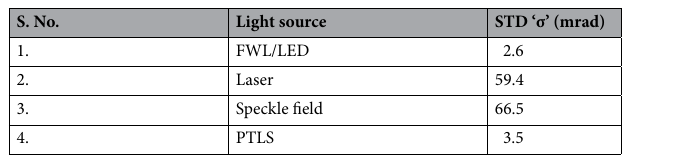
Table 1. Spatial phase sensitivity comparison of different light sources: Standard deviation calculated from the recovered phase maps corresponding to FWL, laser, speckle field and PTLS.